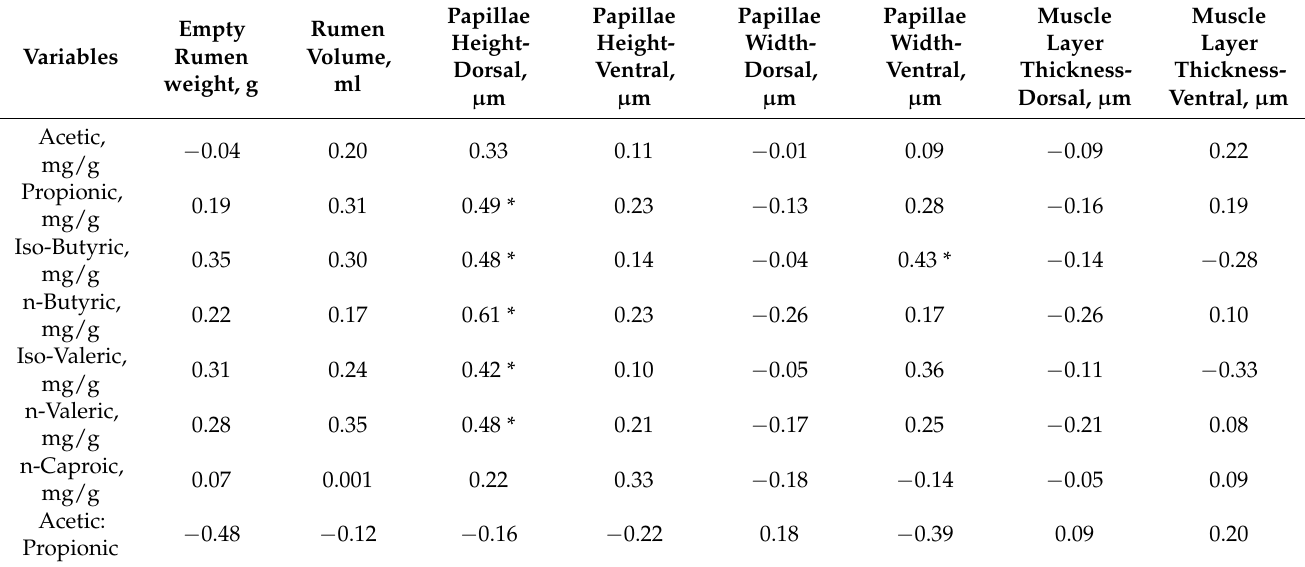
Table A2. Pearson correlation coefficients of rumen metabolic and physical development parameters of artificially reared lambs given three rearing